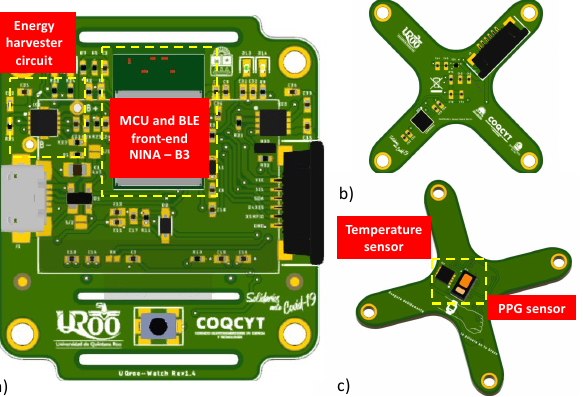
Figure 4. Schematic diagram of the proposed PPG-based prototype. ( a ) main board top view, ( b ) sensors’ board top view and ( c ) sensors’ board bottom view.